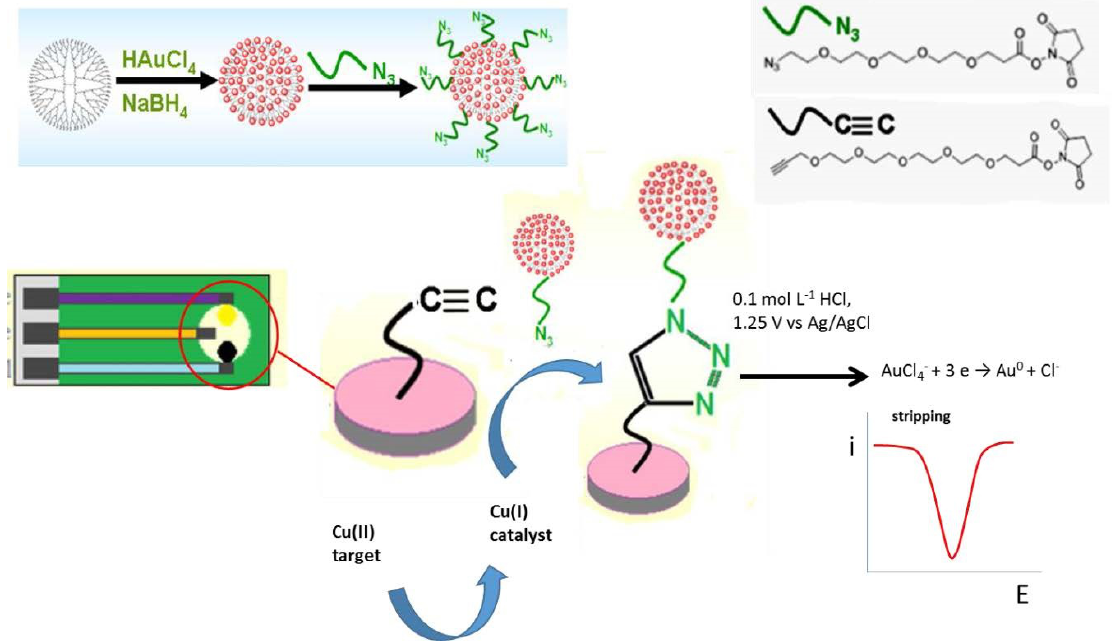
Figure 5. Schematic illustration of the anodic stripping voltammetric detection of Cu 2 + ions by coupling with a Cu(I)-catalyzed azide alkyne click reaction and AuNP-PAMAM signal amplification. Reproduced from [30] with